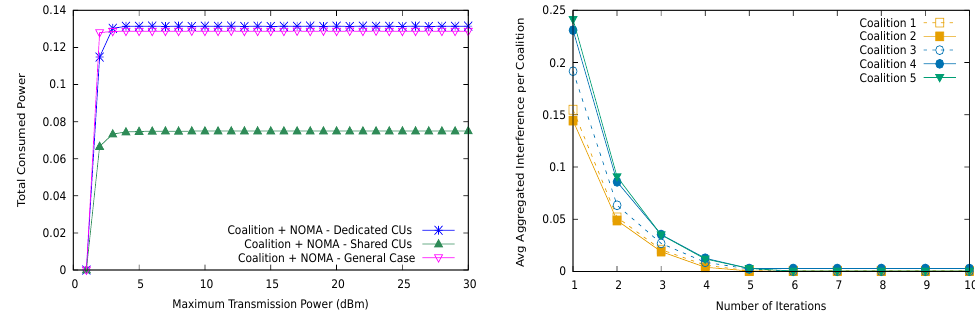
Figure 5. EE mmf and max-min rate for the general case using DL clustering.